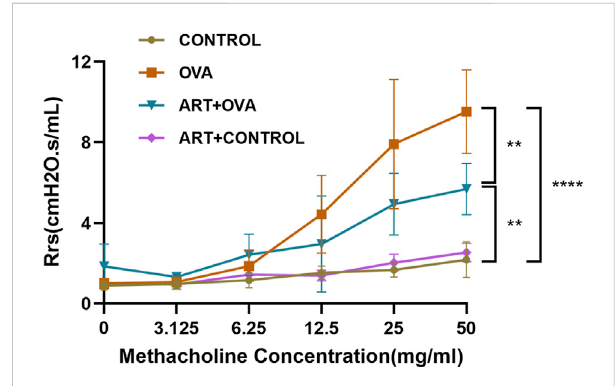
FIGURE 3 The effect of ART on airway hyperresponsiveness in